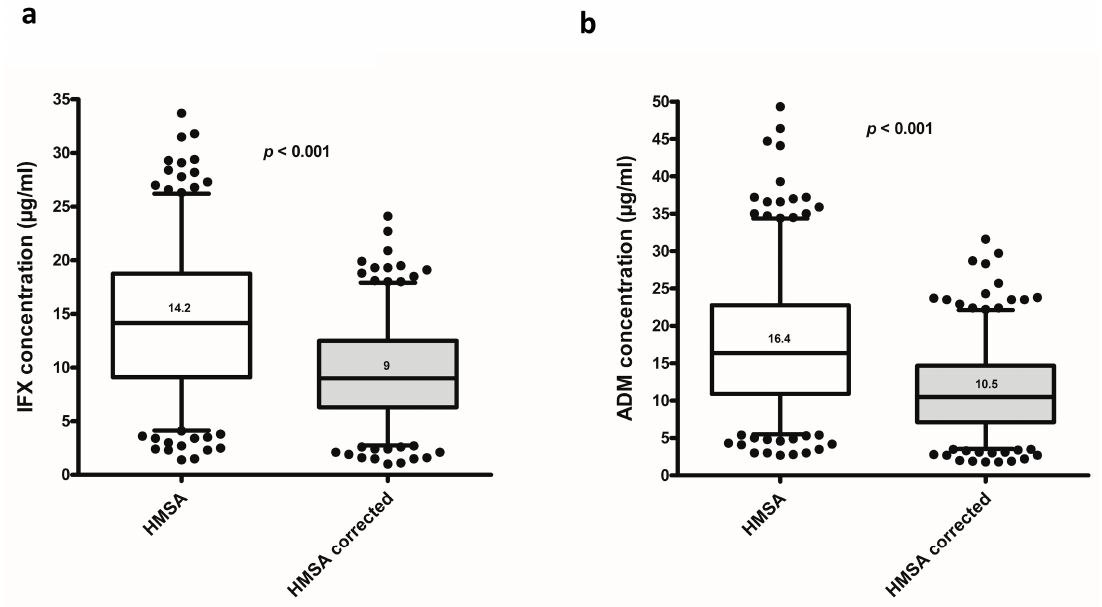
Figure 3. Drug concentrations regarding ( a ) infliximab and ( b ) adalimumab at the last a ff ected TDM before and after the correction of the homogeneous mobility shift assay. Box whisker plots show the median (solid line within box), interquartile range (upper and lower box boundaries), and 5–95% lower and upper extreme (whiskers). Circles represent outliers. Abbreviations: IFX: infliximab; ADM: adalimumab; TDM: therapeutic drug monitoring.